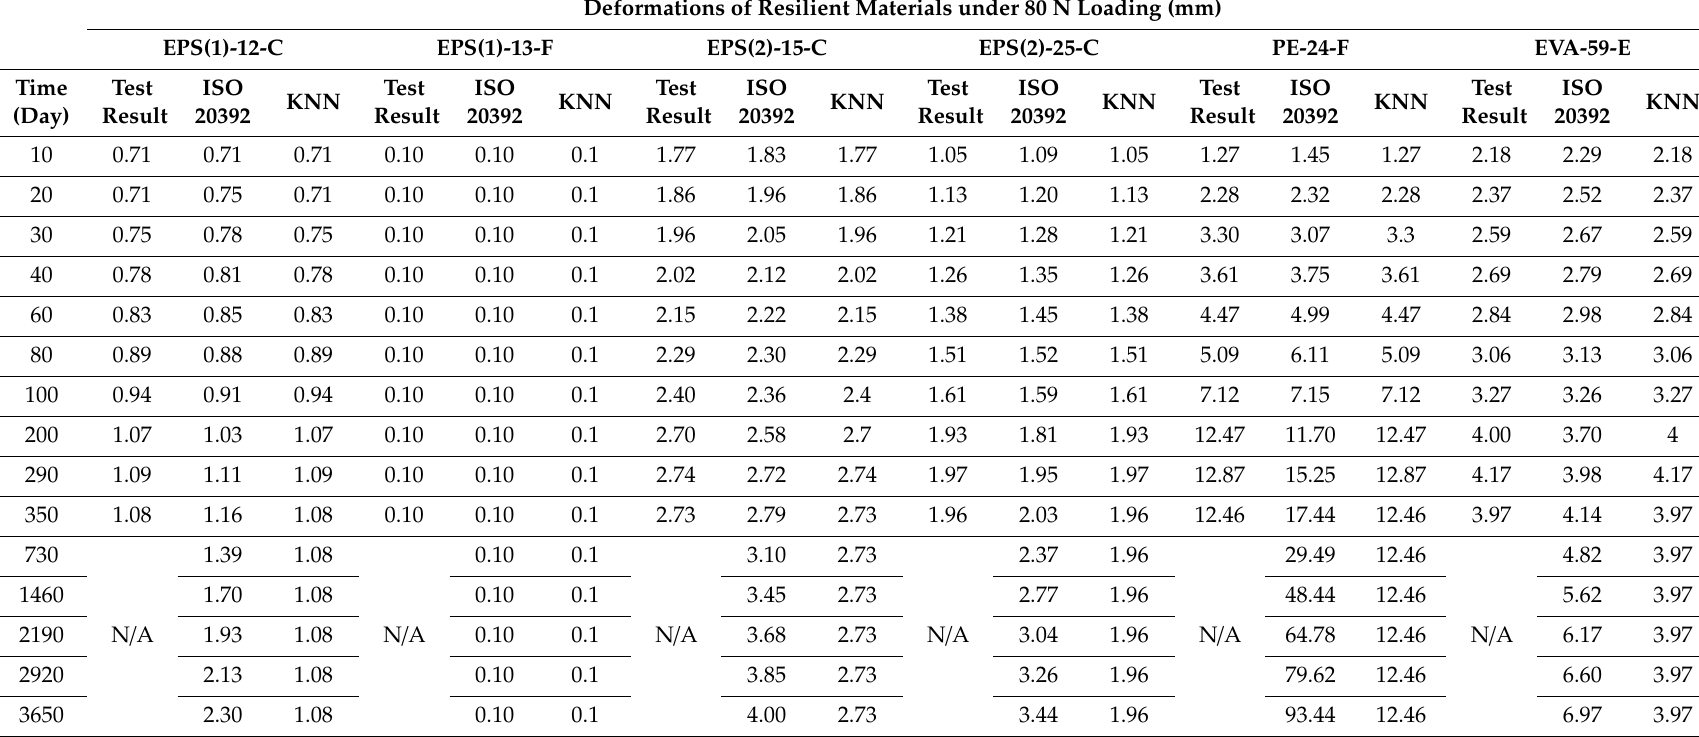
Table A2. Deformations of resilient materials under 80 N